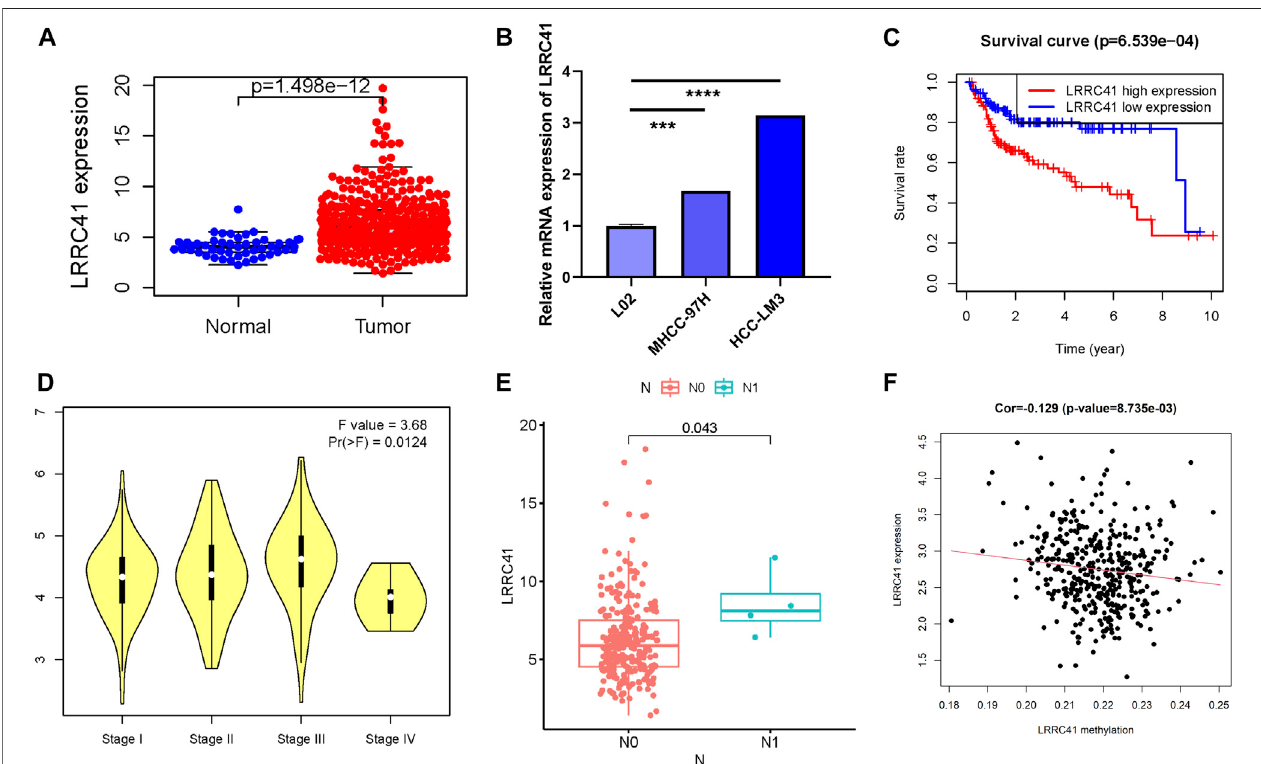
FIGURE 7 | Clinical signi fi cance of LRRC41 in HCC. LRRC41 was upregulated in HCC samples based on the TCGA dataset (A) and experimental validation (B) , and a higher LRRC41 expression level was signi fi cantly correlated with poorer prognosis (C) . The expression of LRRC41 had signi fi cant difference between major pathological stages (D) and tumor N category (E) . (F) The correlation of the LRRC41 expression level with LRRC41 methylation